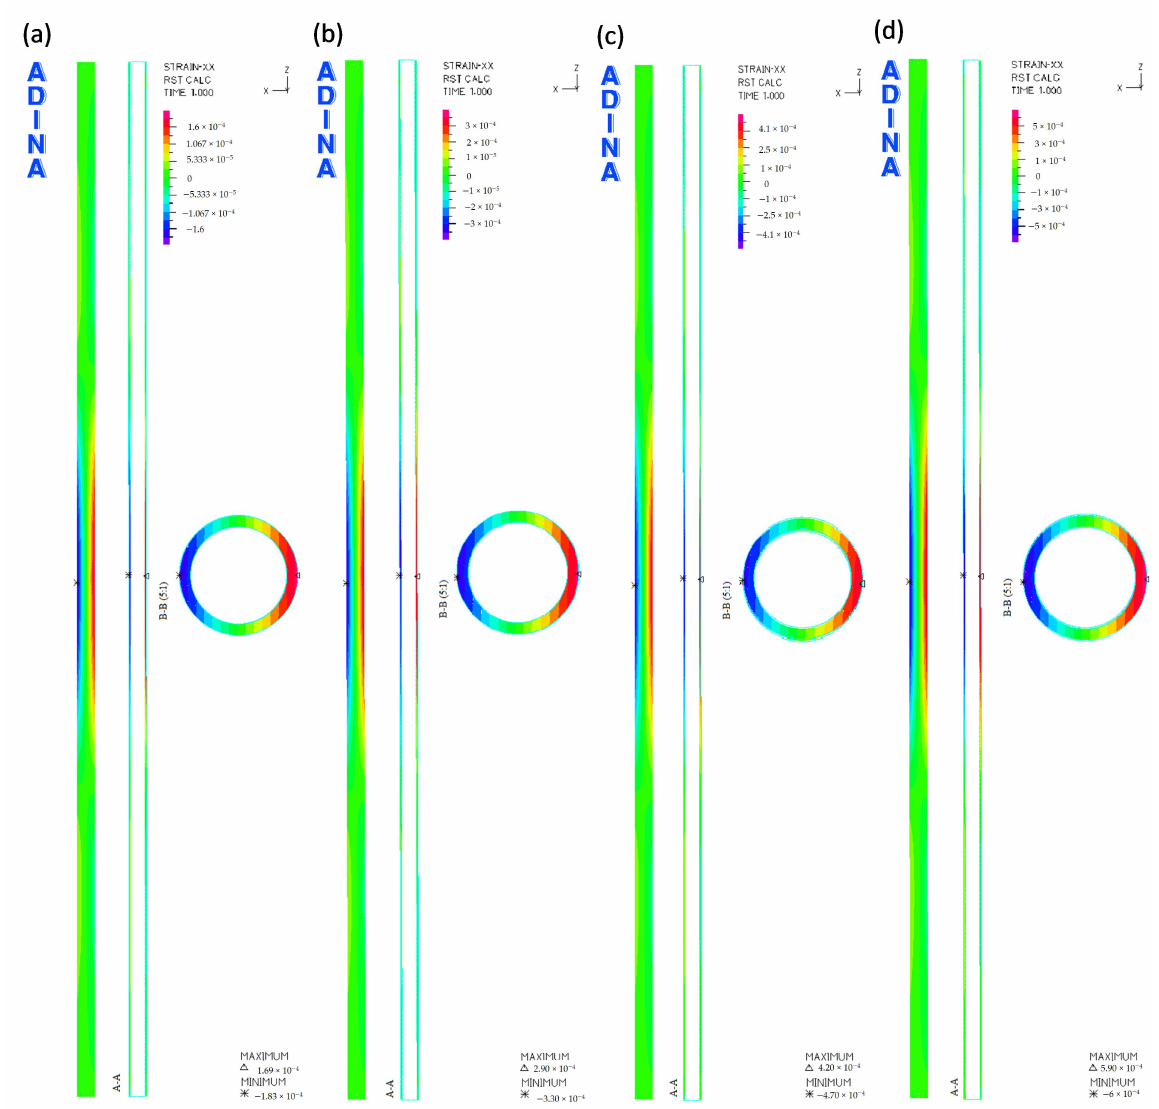
Figure 6. The pipe longitudinal deformations ε x at the following loads: ( a ) 500 N, ( b ) 1000 N, ( c ) 1500 N, ( d ) 2000 N. The nature of the longitudinal deformations of the pipe is the same for each load